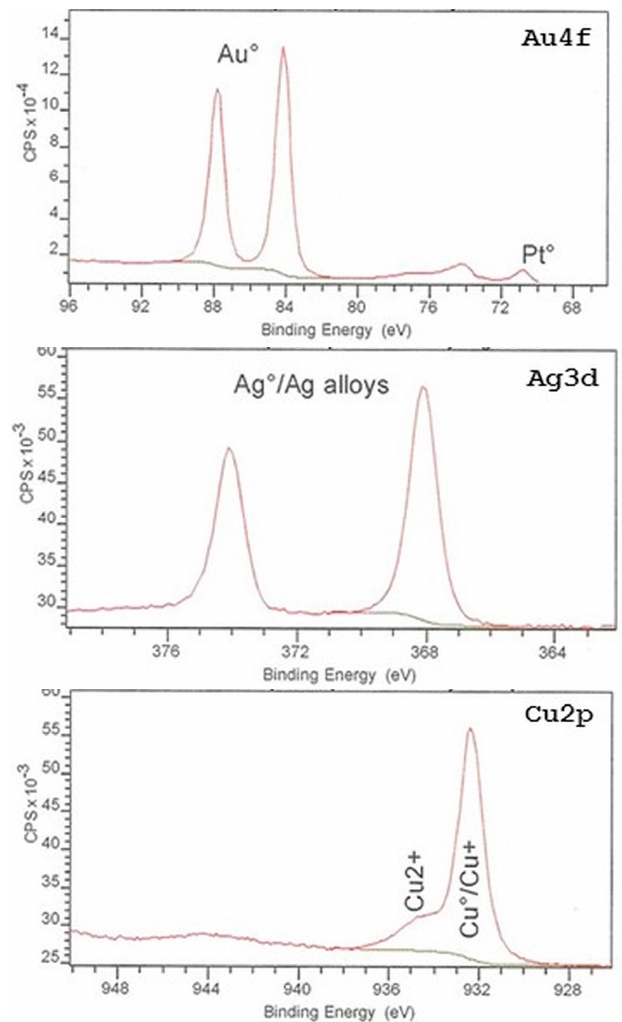
Figure 6. X-ray photoelectron spectroscopy (XPS) spectra of Au4f, Ag3d, and Cu2p for type IV Au alloy.